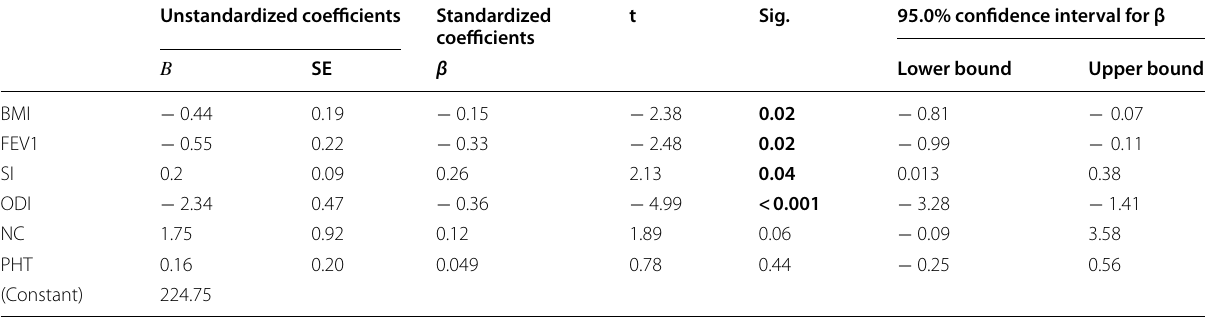
Table 8 Multiple regression analysis of age BMI, post FEV1, smoking index, baseline O variable for